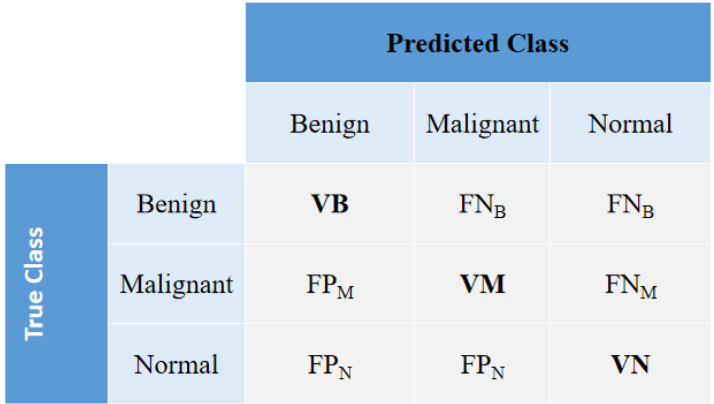
Figure 3. The confusion matrix highlighting the performance accuracy of the classification of mam- mogram images, with the diagonal elements in bold representing the true prediction